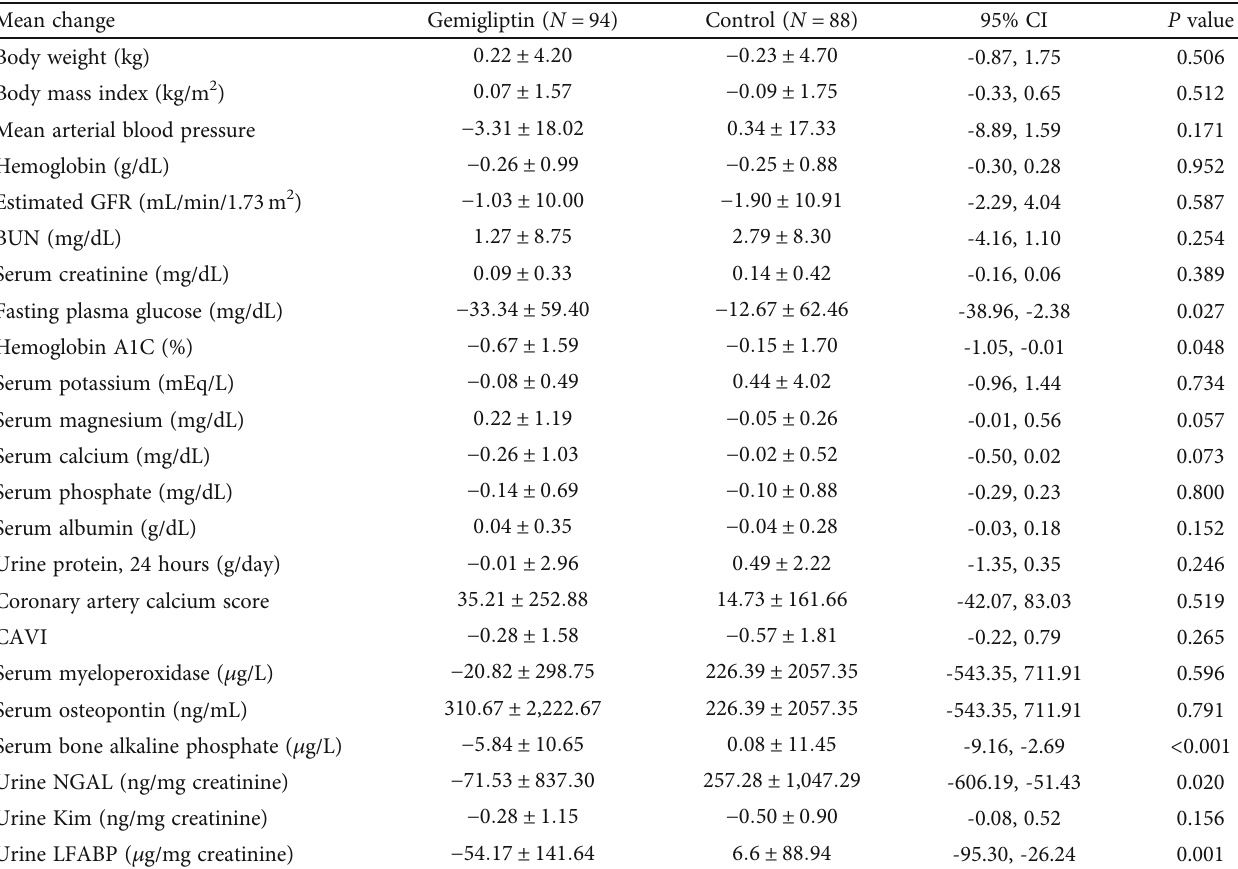
Table 4: Comparison of mean changes in various parameters from baseline to month 6 between the two